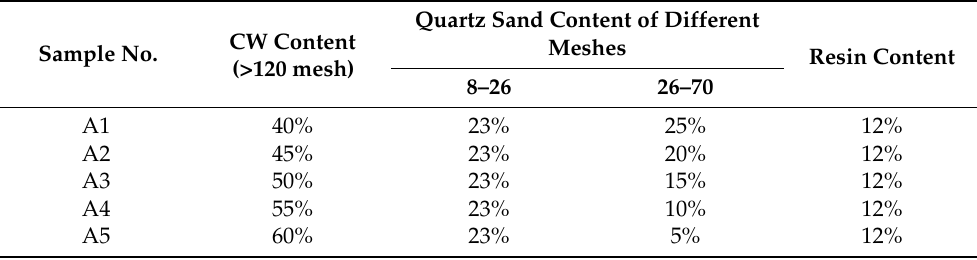
Table 1. Batching of Group A samples with fine ceramic waste powder instead of quartz sand (in mass fraction).